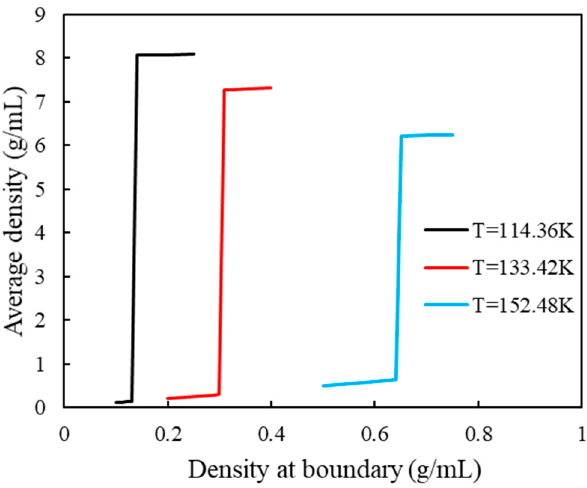
Figure 3. Average density in a 10 nm capillary tube changes with density at boundary under different temperatures.